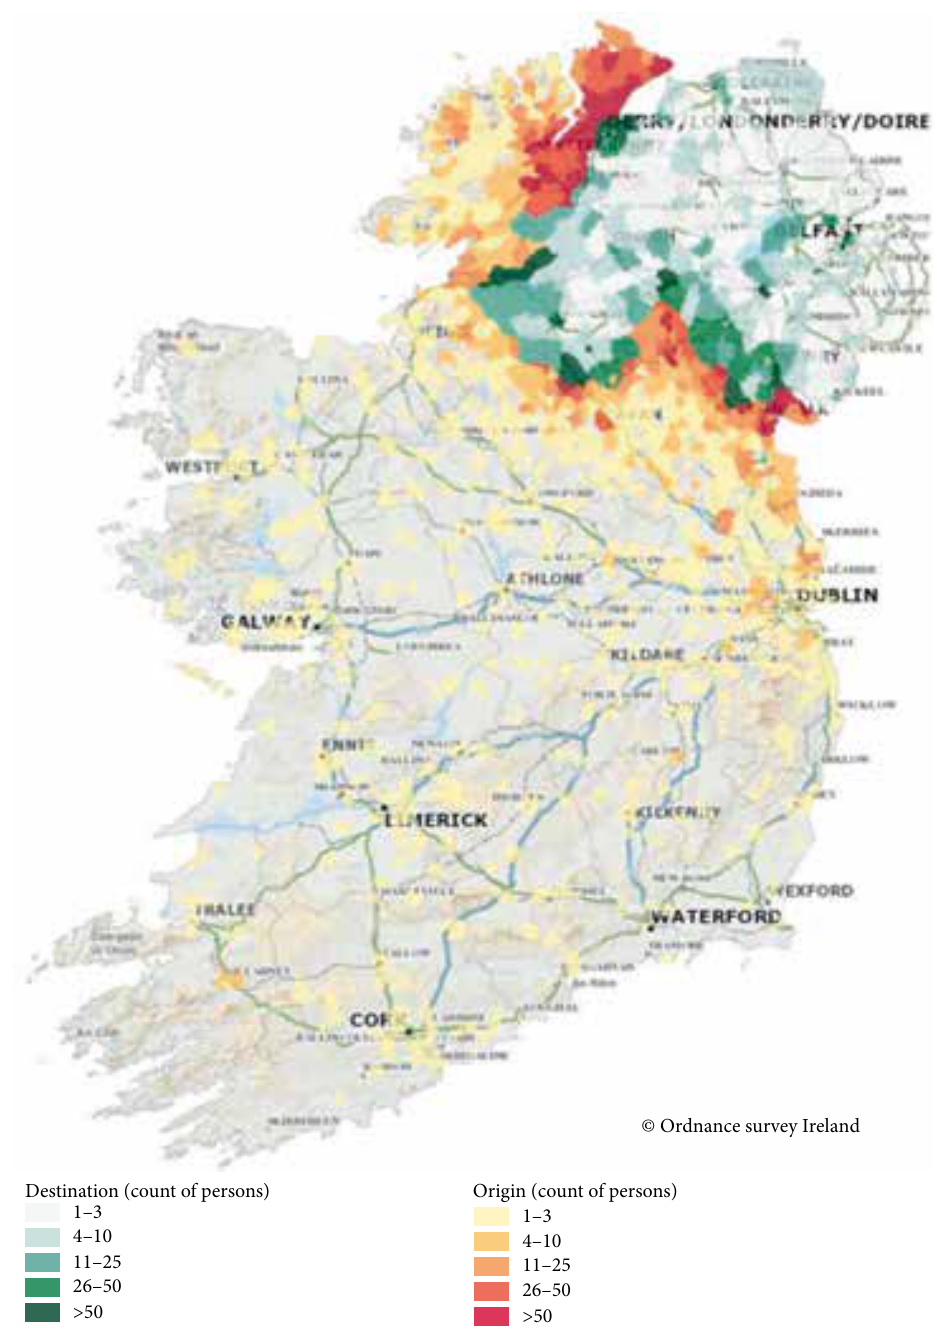
Figure 2: Cross‐border commuters from Ireland to Northern Ireland